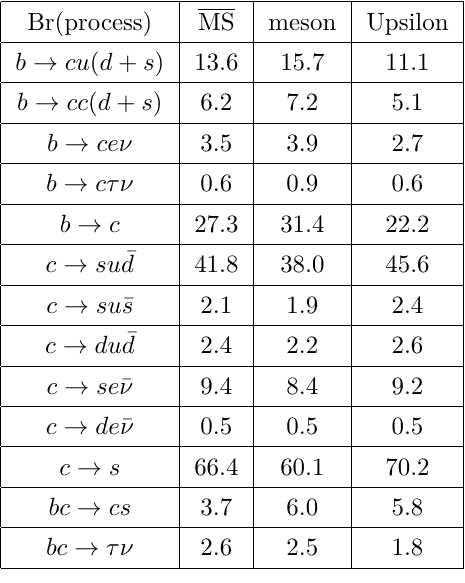
Table 6 . Branching fractions in per-cent for B c semi-inclusive decays in the MS, meson, and Upsilon schemes. The WA into cs and the PI have been combined into a single bc → cs branching